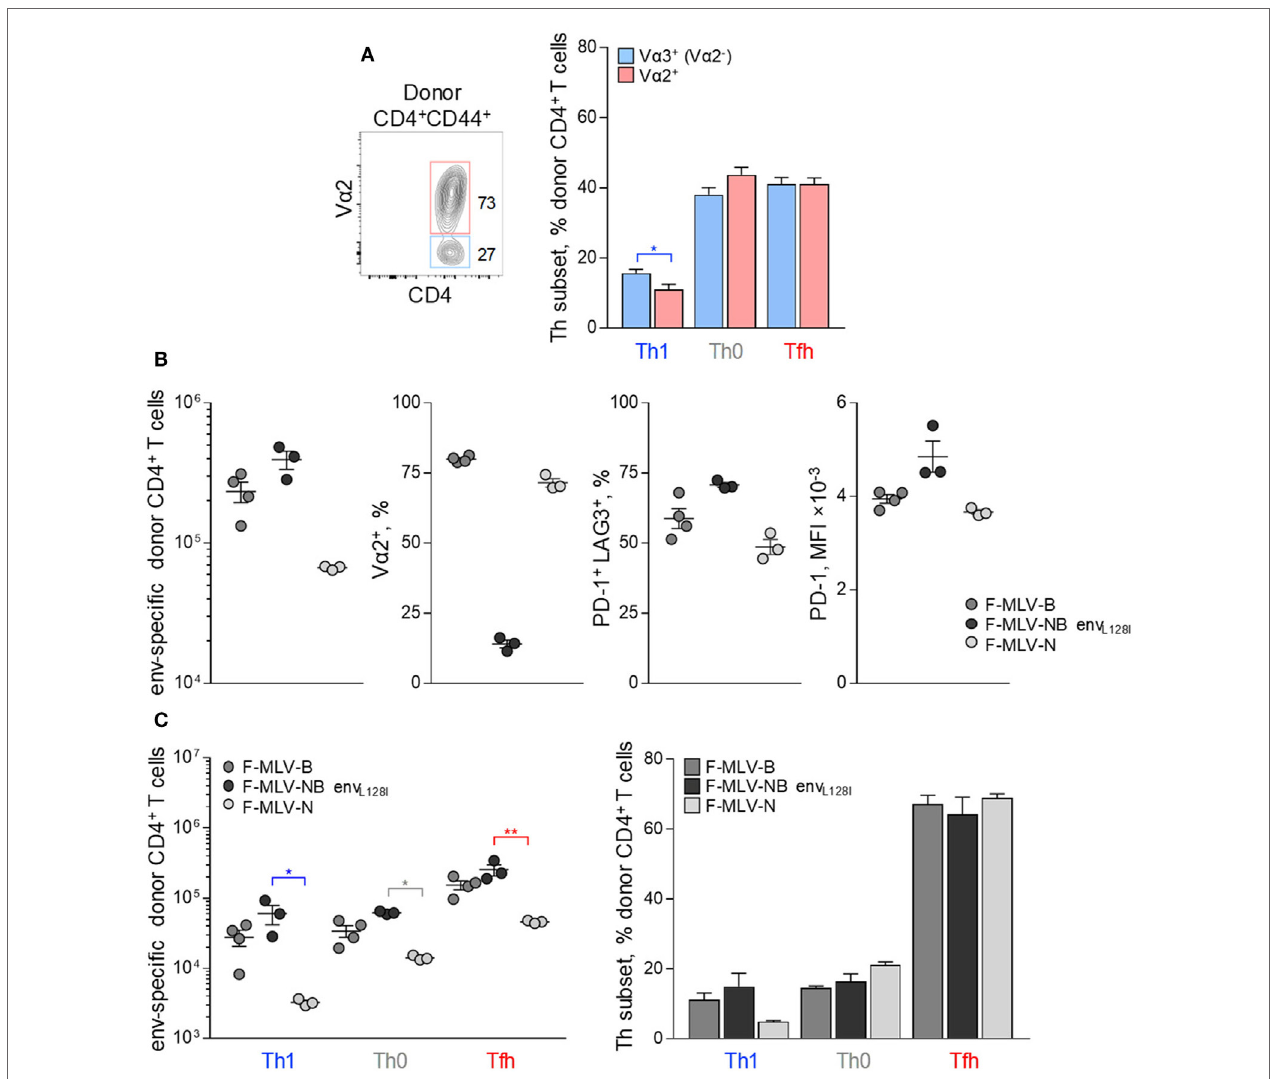
FigUre 4 | Effect of TCR avidity on the follicular helper cells (Tfh) response to F-MLV env. (a) Flow cytometry example of V α 2 expression ( left ) and mean frequency ( ± SEM) ( right ) of T helper (Th) subsets, defined by PSGL1 and CXCR5 expression, in V α 2 + or V α 3 + (V α 2 − ) env-reactive donor CD4 + T cells, 7 days after transfer into Friend virus (FV) infected recipients ( n = 10). (B) Characterization of clonal expansion and expression of V α 2, PD-1, and LAG3 in env-reactive donor CD4 + T cells, 7 days post-transfer in WT recipient mice infected with ~10 4 infectious units of F-MLV-B, F-MLV-NB env L128I , or F-MLV-N. (c) Absolute number ( left ) and mean frequency ( ± SEM) ( right ) of Th subsets, defined by PSGL1 and CXCR5 expression, in env-reactive donor CD4 + T cells from the same donor cells as in (B) . One representative of two experiments with n = 4, n = 3, and n = 3 mice for F-MLV-B, F-MLV-NB env L128I , and F-MLV-N infection, respectively, is